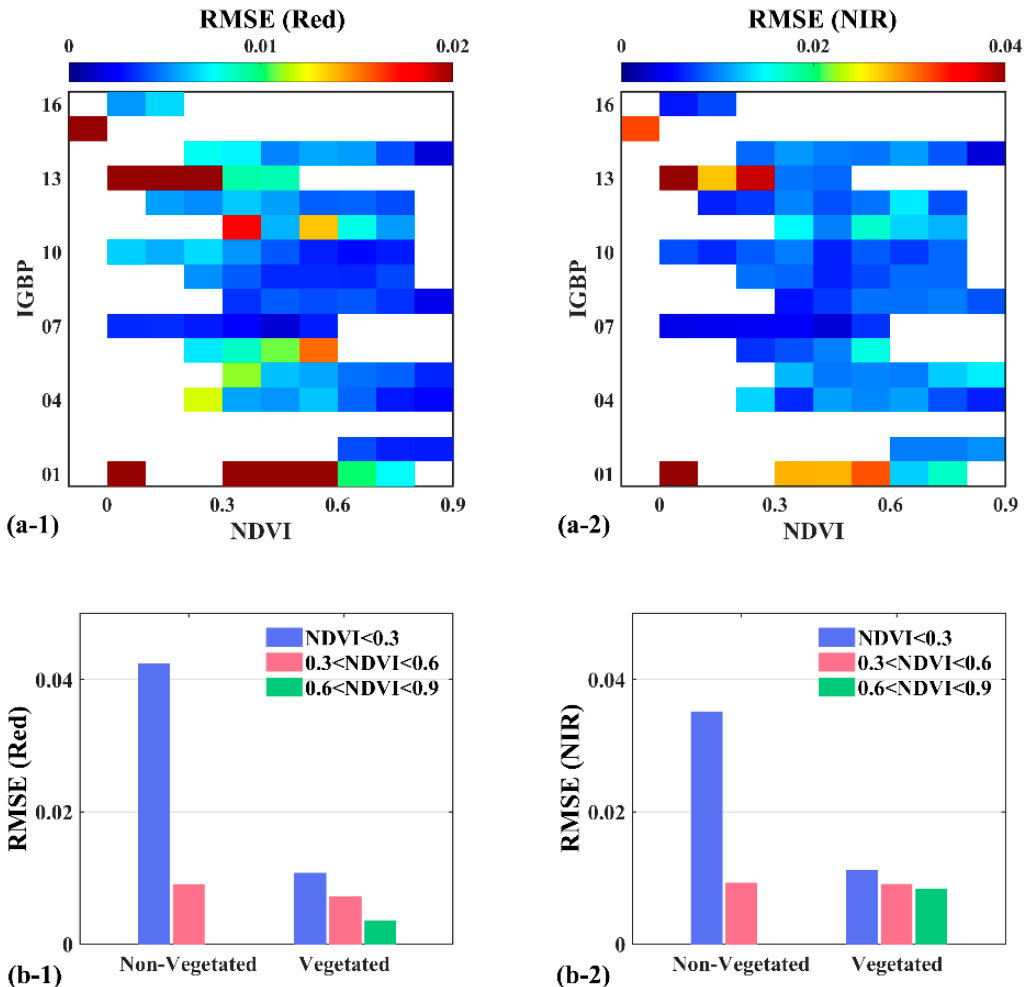
Figure 3. Fitting residuals of the RTLSR model for different land covers and NDVI levels in the red (1) and NIR (2) bands; ( a-1 , a-2 ) are values of the fitting residuals over different IGBP types, the colors correspond to RMSE values from low (blue) to high (red), and the blank areas mean no data. ( b-1 , b-2 ) show the fitting residuals of the RTLSR model on non-vegetated and vegetated lands. IGBP list: 01 Evergreen Needleleaf Forests; 02 Evergreen Broadleaf Forests; 03 Deciduous Needleleaf Forests; 04 Deciduous Broadleaf Forests; 05 Mixed Forests; 06 Closed Shrublands; 07 Open Shrublands; 08 Woody Savannas; 09 Savannas; 10 Grasslands; 11 Permanent Wetlands; 12 Croplands; 13 Urban and Built-Up Lands; 14 Cropland/Natural Vegetation Mosaics; 15 Snow and Ice; and 16 Barren. Climate, land cover, vegetation density, and sun-sensor geometry are affected by latitude and time, which means that the RTLSR model should have different applicability at different latitudes and times. In the present study, we analyzed the spatial and temporal characteristics of the fitting residuals of the RTLSR model using observations at different latitudes and times (Figure 5). It can be found that the larger fitting residuals are at the four corners in the heat maps of the red and NIR bands. As the top line plot show, the mean fitting residuals of RTLSR reach 0.0444 and 0.0483 at high latitudes in the red and NIR bands, respectively. The reason should be that at high latitudes the land cover is mainly non-vegetated lands (wasteland or snow and ice) and vegetation is sparse, the SZA is also larger. The mean fitting residuals on different months are reflected in the right line plot in the red band (Figure 5a). The relationship between RMSE and time is weak. This suggests that the adaptability of the RTLSR model is not strongly correlated with time. Similar